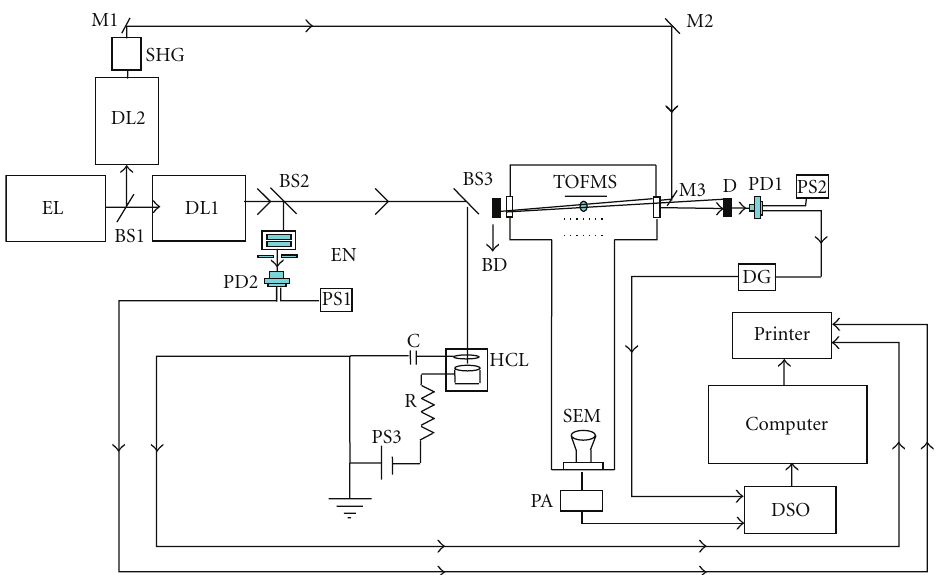
Figure 1: Schematic of the experimental setup of a resonance ionisation mass spectrometry (RIMS) system. BS: beam splitter, BD: beam dump, C: capacitor, D: di ff usor, DG: delay generator, DL: dye laser, DSO: digital storage oscilloscope, EL: excimer laser, EN: 7.5GHz air spaced etalon, HCL: hollow cathode lamp, M: mirror, PA: preamplifier, PD: photo diode, PS: power supply, R: current limiting resistor, SEM: secondary electron multiplier, SHG: frequency doubler, TOFMS: time-of-flight mass